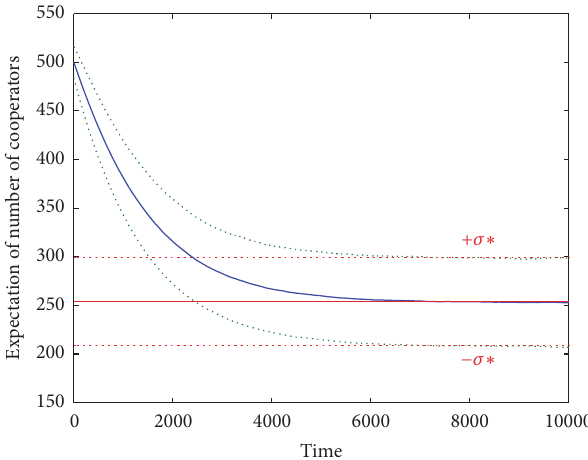
Figure 4: Time evolution of the number of the cooperators: the graph (in solid blue) is the ensemble average of 100,000 times of the Monte Carlo realizations with 𝛼 = 3 . The number of the cooperators converges to the equilibrium (in solid red) which is analytically evaluated in (6).